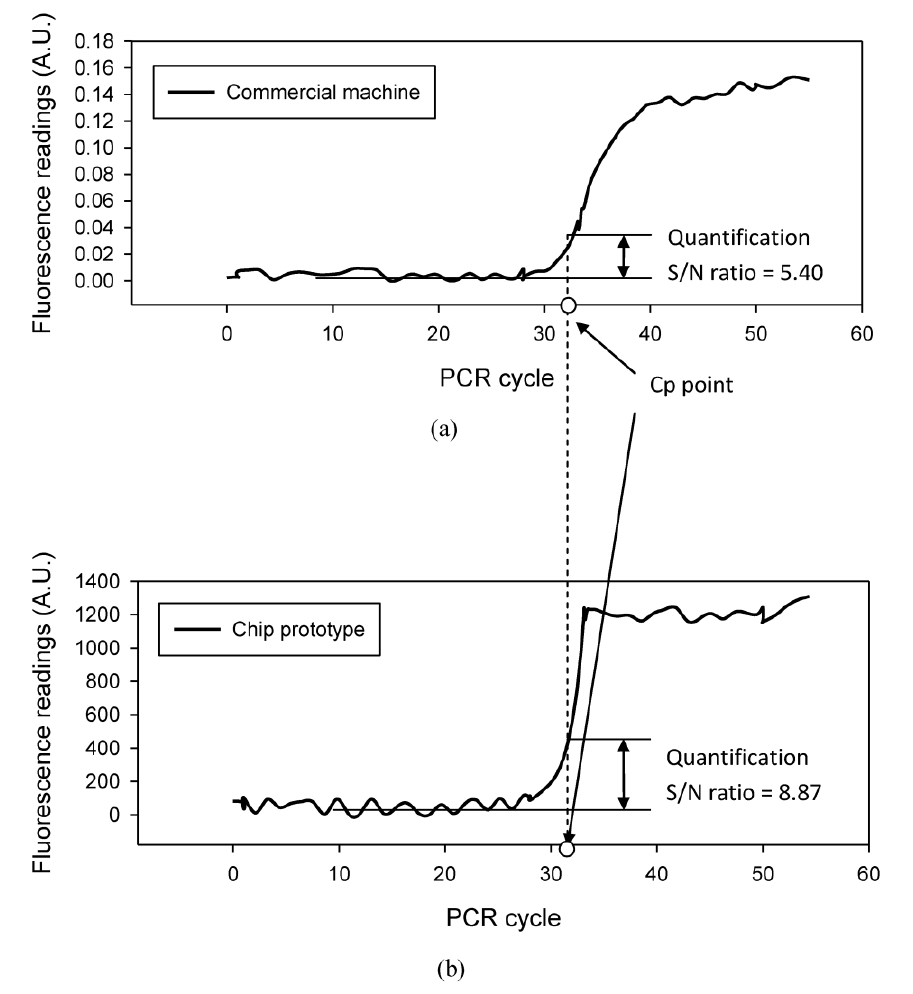
Figure 8. Fluorescence increment curves obtained by the commercial machine (a) and the chip (b) from the sample of 10 5 initial copies per reaction. The figures illustrate that the chip-orientated fluorimeter design provides a higher S/N ratio than the commercial machine at the same detection point, Cp. The higher S/N ratio indicates achieving more sensitive detection in the 1 nano-liter volume by the